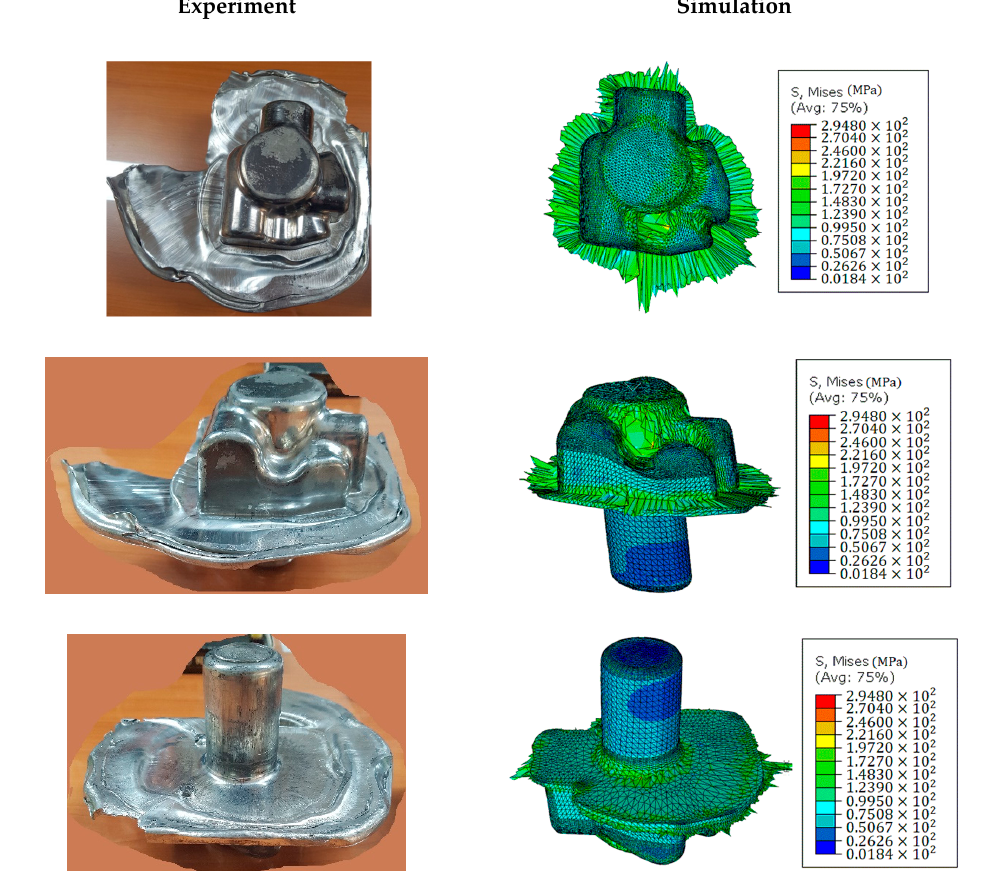
Figure 16. Experiment result of warm forging (produced final